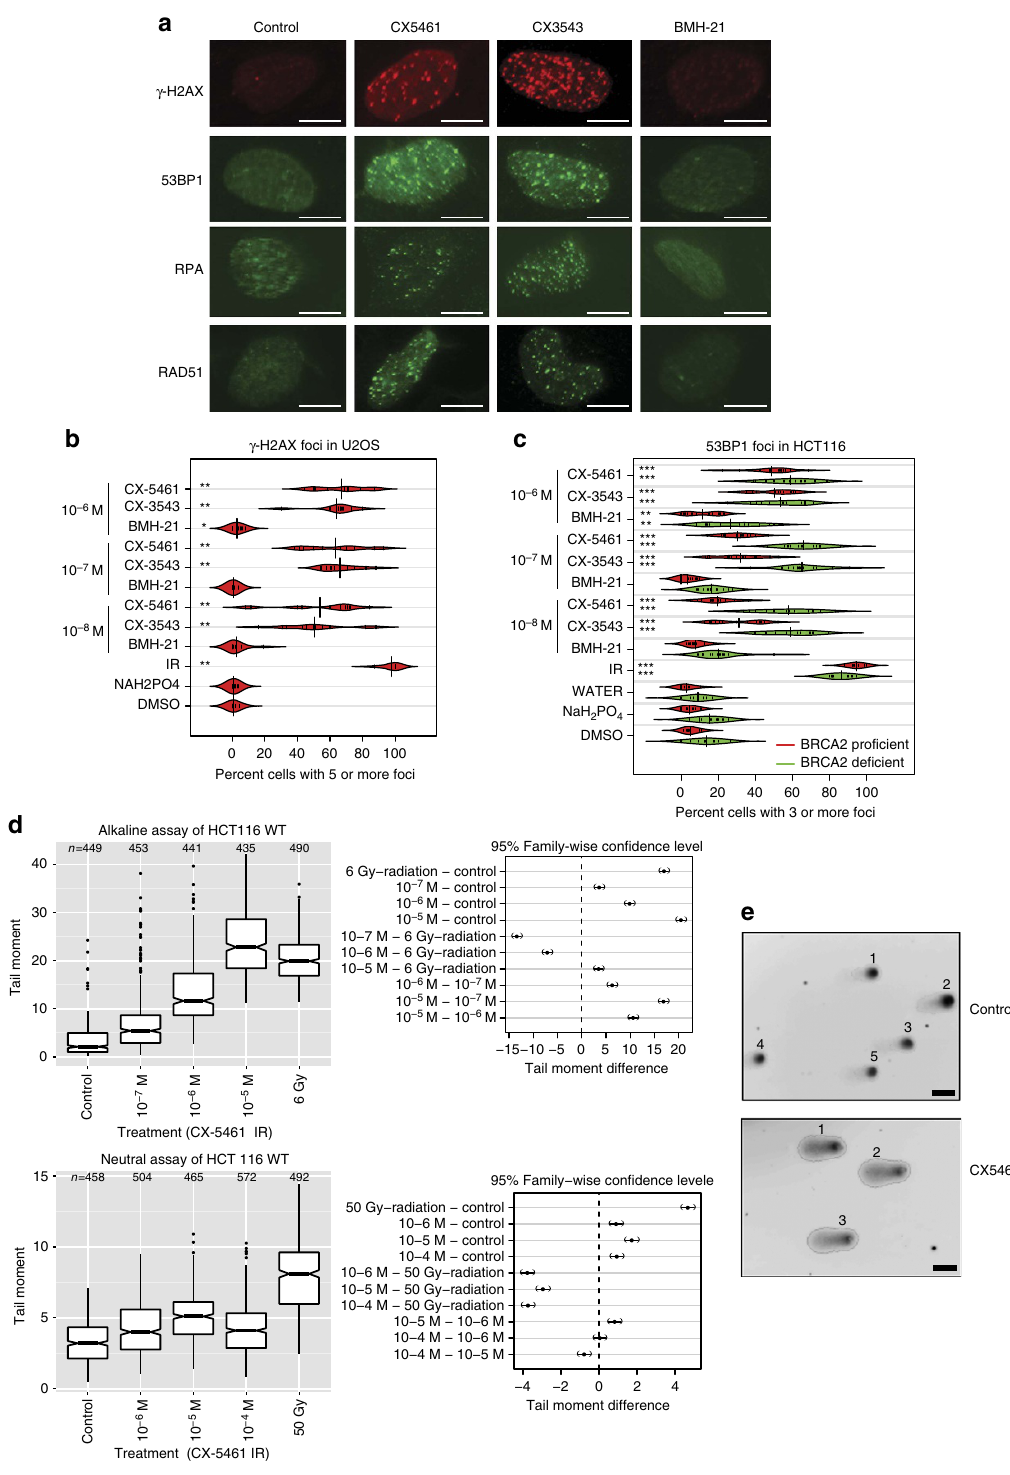
Figure 2 | DNA damage is induced in cells with CX-5461 and CX-3543 treatment. ( a ) The formation of g -H2AX, 53BP1, RPA and RAD51 foci was monitored upon CX-5461, CX-3543 and BMH-21 treatment at 10 (cid:2) 7 M in U2OS cells. Drug treatment time is 24h for all drugs. Scale bar, 10 m M. ( b ) Beanplots of U2OS cells showing five or more g -H2AX foci for the indicated drug treatment condition after 24h. ** P o 0.01 (one tailed randomization tests adjusted for multiple comparisons relative to vehicle control); n ¼ 2 experiments, (35–150 cells were counted each time per each condition). DMSO was the vehicle control solvent for CX-3543 and NaH 2 PO 4 was the vehicle control solvent for BMH-21 and CX-5461. ( c ) Beanplots of HCT116 cells showing three or more 53BP1 foci for the indicated drug treatment conditions after 24h. ** P o 0.01, *** P o 0.0001 (one-tailed randomization tests adjusted for multiple comparisons relative to vehicle control); n ¼ 3 experiments; 4 100 cells per replicate condition. ( d ) Quantification of alkaline comet and neutral comet assay result upon CX-5461 treatment (30min) in HCT116. Tail moments were determined as described in Methods; ( n ¼ 3 experiments, 100 cells were counted in each replica), mean and 95% CI are shown. Right panels show pair-wise comparison of condition contrasts and 95% CIs of tail moment difference. ( e ) Representative images of alkaline comet assay of cells treated with CX-5461 (10 (cid:2) 6 M, 30min) and no drug control. Scale bar, 20 m